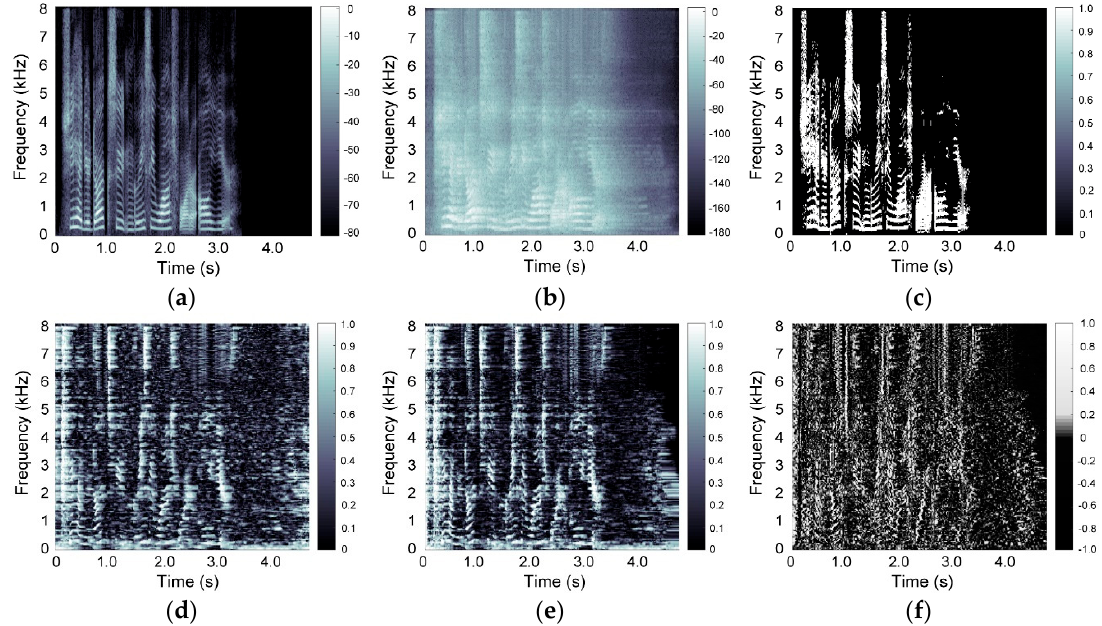
Figure 5. Averaged MAC total using STFT with a 64-ms Hamming window, 16-ms hop length, and 1024-point FFT for 1680 speech samples of conventional and proposed methods in ( a ) 0.37 s, ( b ) 0.69 s, and ( c ) 0.79 s of RT 60 . Appl. Sci. 2020 , 10 , 769